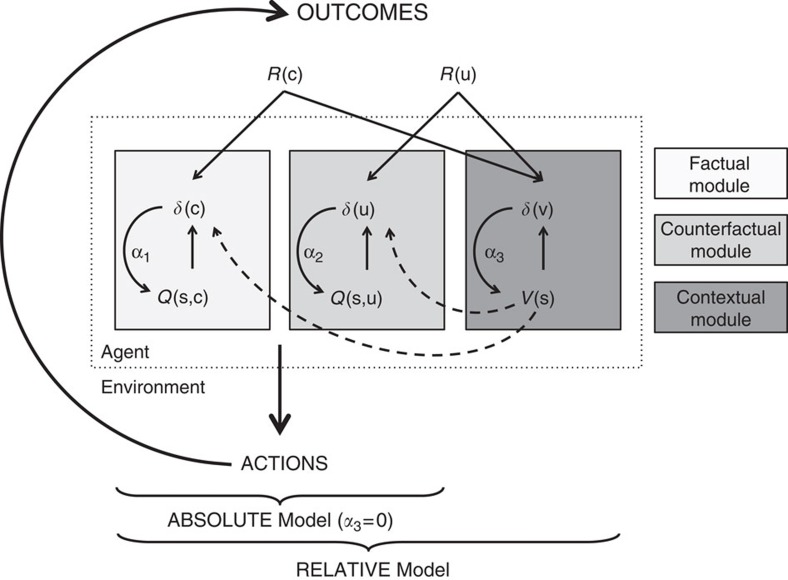
Computational architecture.The schematic illustrates the computational architecture used for data analysis. For each context (or state) ‘s', the agent tracks option values (Q(s,:)), which are used to decide amongst alternative courses of action. In all contexts, the agent is informed about the outcome corresponding to the chosen option (R(c)), which is used to update the chosen option value (Q(s,c)) via a prediction error (δ(c)). This computational module (‘factual learning') requires a learning rate (α1). In the complete feedback condition, the agent is also informed about the outcome of the unselected option (R(u)), which is used to update the unselected option value (Q(s,u)) via a prediction error (δ(u)). This computational module (‘counterfactual learning') requires a specific learning rate (α2). In addition to tracking option value, the agent also tracks the value of the context (V(s)), which is also updated via a prediction error (δ(v)), integrating over all available feedback information (R(c) and R(u), in the complete feedback contexts and Q(s,u) in the partial feedback contexts). This computational module (‘contextual learning') requires a specific learning rate (α3). The RELATIVE model can be reduced to the ABSOLUTE model by suppressing the contextual learning module (that is, assuming α3=0).